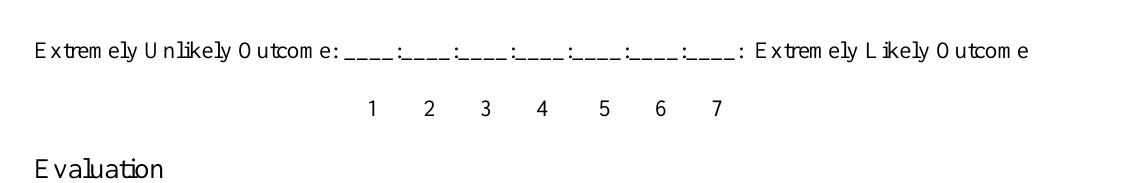
Sample Items from the Attitudinal Scale Behavioural belief (outcome belief) Likelihood Inclusion will have a positive effect on the development of personalities of students with physical disabilities (e.g. self esteem, feeling of belonging,